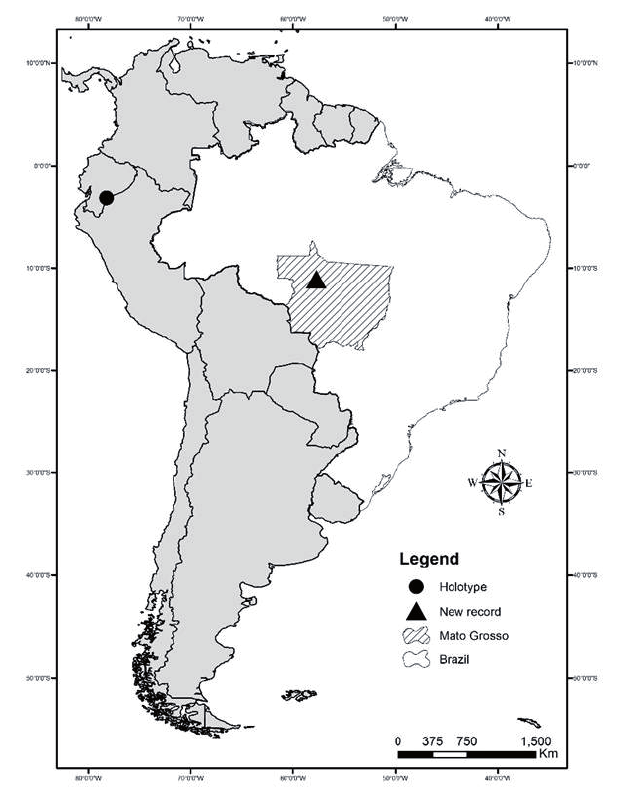
disturbances. Fig 1. Distribution map of Gnamptogenys vriesi